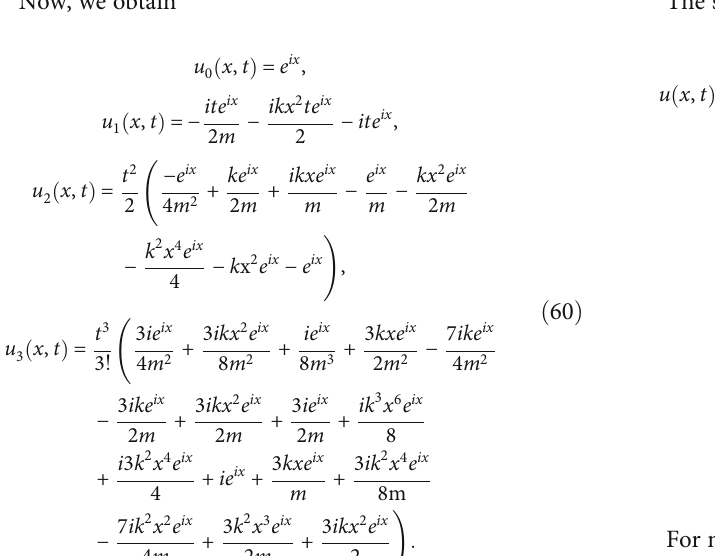
Figure 11: SADM and PSADM solutions using 3